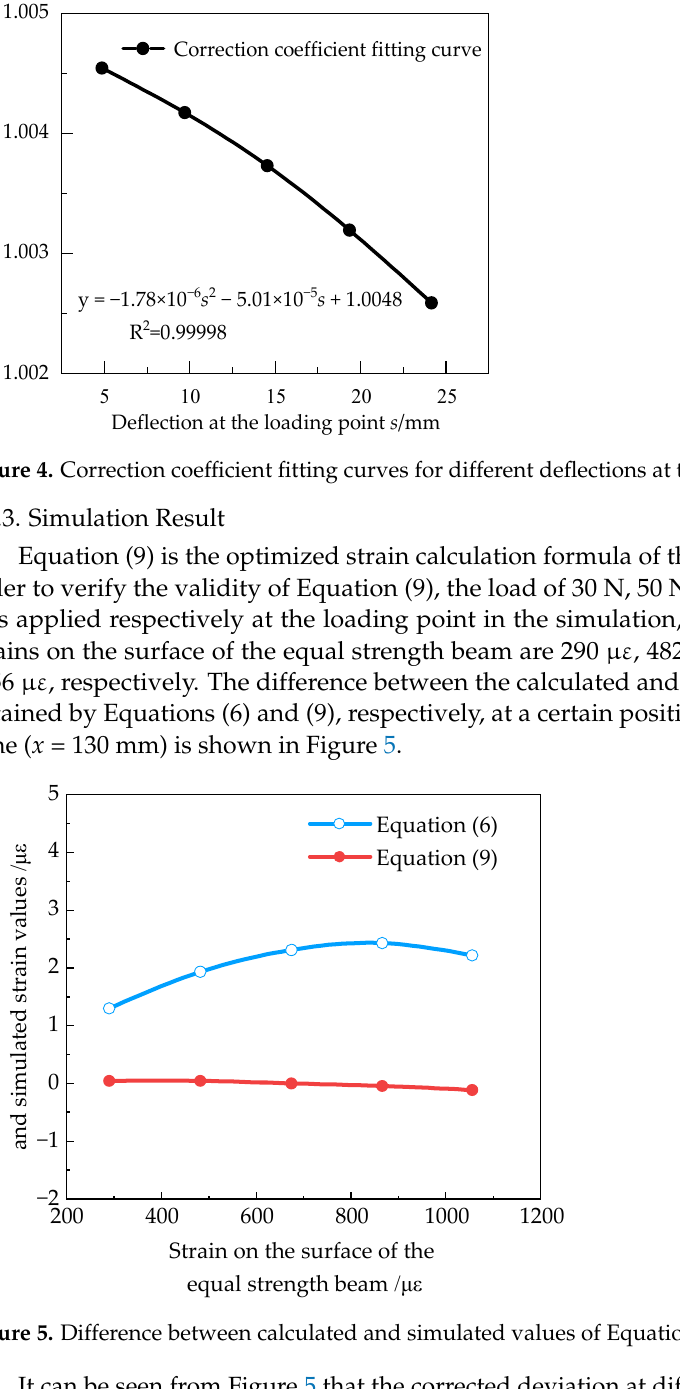
Figure 5. Difference between calculated and simulated values of Equations (6) and (9).